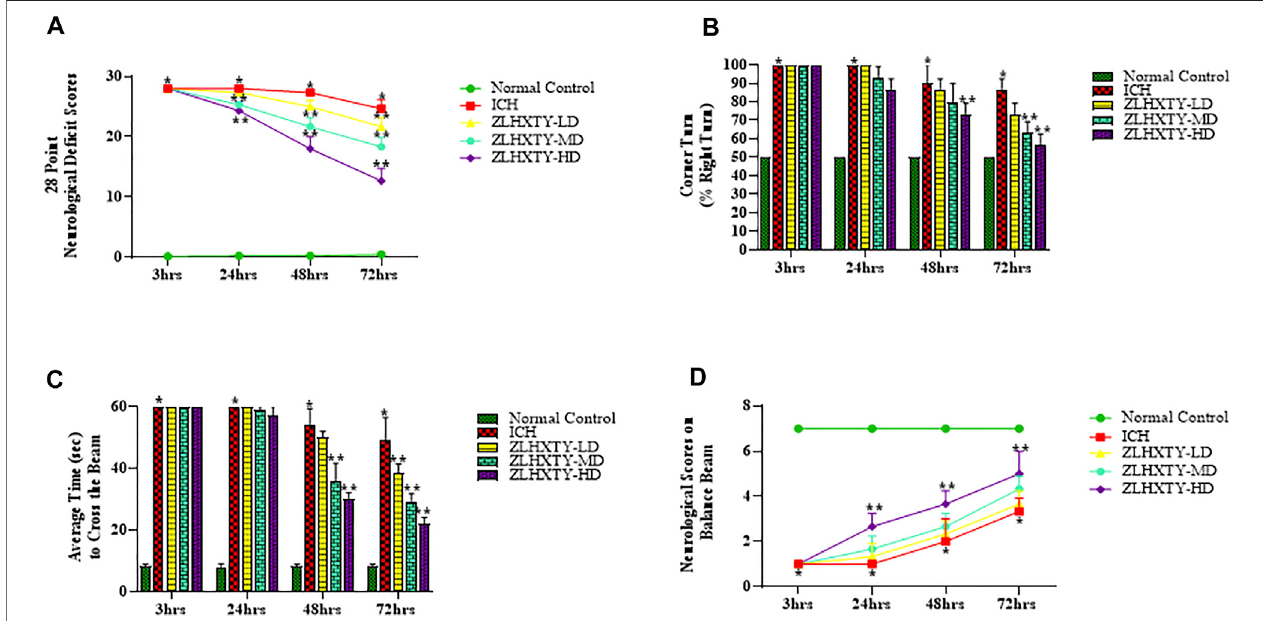
FIGURE 2 | Effect of ZLHXTY capsules on neurological outcomes in mice after ICH. (A) 28 point neurological de fi cit score, (B) corner turn test (% right turn), (C) balance beam test and (D) neurologicalscoring on balance beam; revealed signi fi cantalleviation ofneurological de fi cits after ZLHXTY capsules treatment after 72 hrsof ICH. Data represent the mean ± SD, n = 18, * p < 0.05 as compared to normal control, ** p < 0.05 as compared to ICH group.